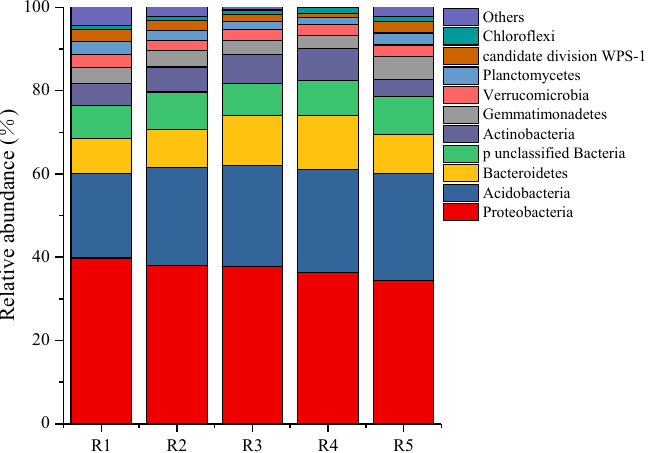
Figure 2. The relative abundance of bacterial community composition in the phylum level. R1, R2, R3, R4, and R5 represent planting years for 1, 2, 3, 4, and 5 years, respectively. At the bacterial class level (Figure 3), the dominant bacteria of all samples were Al- phaproteobacteria (22.20–28.06%), Acidobacteria Gp4 (10.37–12.79%), Acidobacteria GP6 (6.11–7.87%), Sphingobacteriia (6.31–8.49%), Actinobacteria (4.09–7.54%), Betaproteobac- teria (5.08–6.05%), Gammaproteobacteria (4.62–5.47%), Gemmatimonadetes (3.04–5.53%).